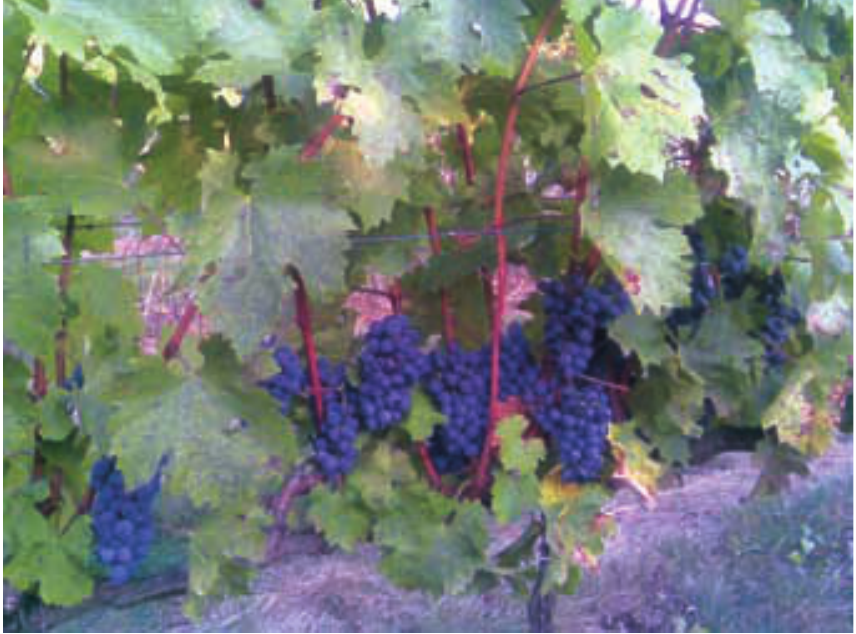
Figure 4: Cabernet sauvignon vinestock in Cserszegtomaj,